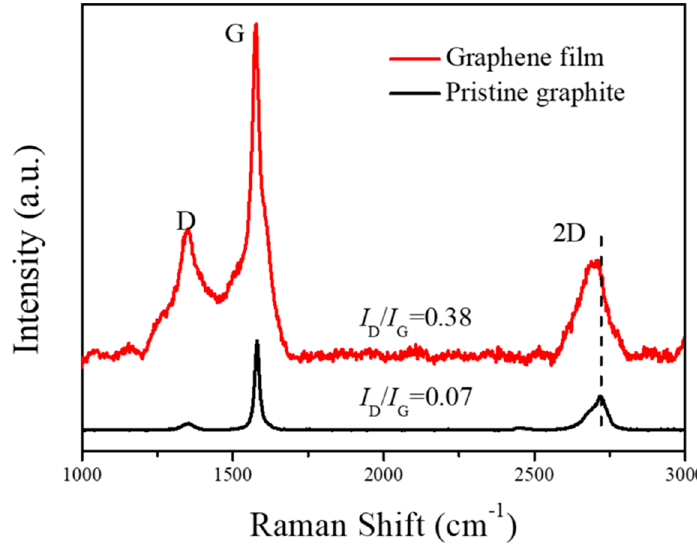
Figure 6. Raman spectra of pristine graphite and the as-prepared graphene film.